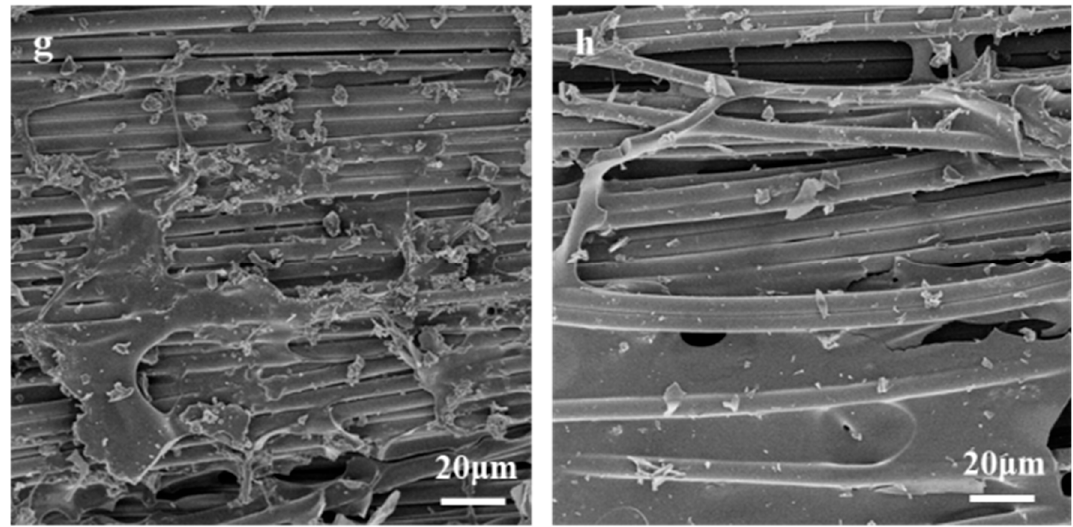
Figure 8. Scanning electron microscopy (SEM) images of the external surfaces of burned RTM epoxy composites preformed by ET3228 tackifiers containing ( a ) 0, ( b ) 23, ( c ) 38 and ( d ) 48 wt.% MRP, and inner surfaces of burned RTM epoxy composites preformed by ET3228 tackifiers containing ( e ) 0, ( f ) 23, ( g ) 38 and ( h ) 48 wt.% MRP.